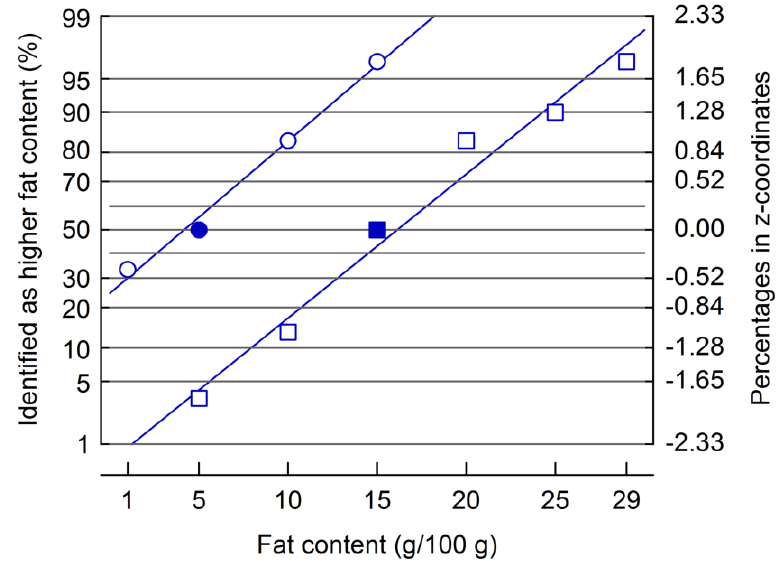
Figure 4. Plot of percentages of samples identified as being higher in fat content (left y -axis: percentage in normal probability grid, right y -axis: z -coordinates) as a function of emulsion fat content. Reference fat content (full symbols) was 5 g/100 g and 15 g/100